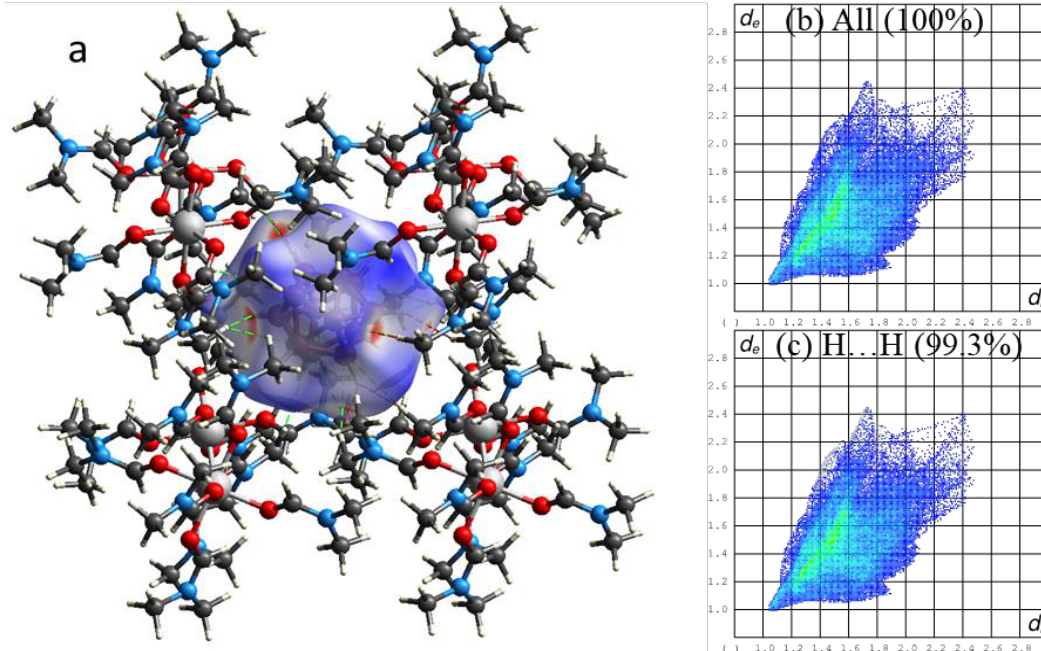
Figure 2. ( a ) d norm surface of compound 1 ∙ , ( b ) full two-dimensional fingerprint plot for the [B 12 H 12 ] 2 – anion together with that delineated into H…H ( c ) contacts.